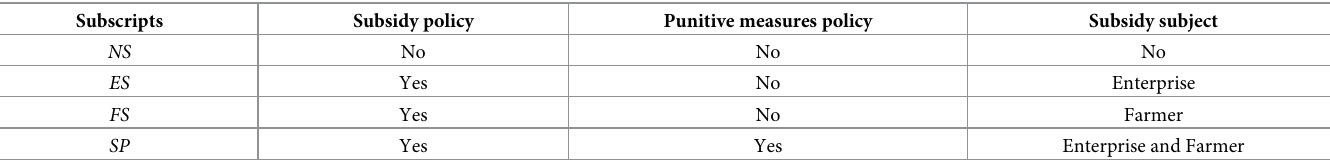
Table 3. Subscripts